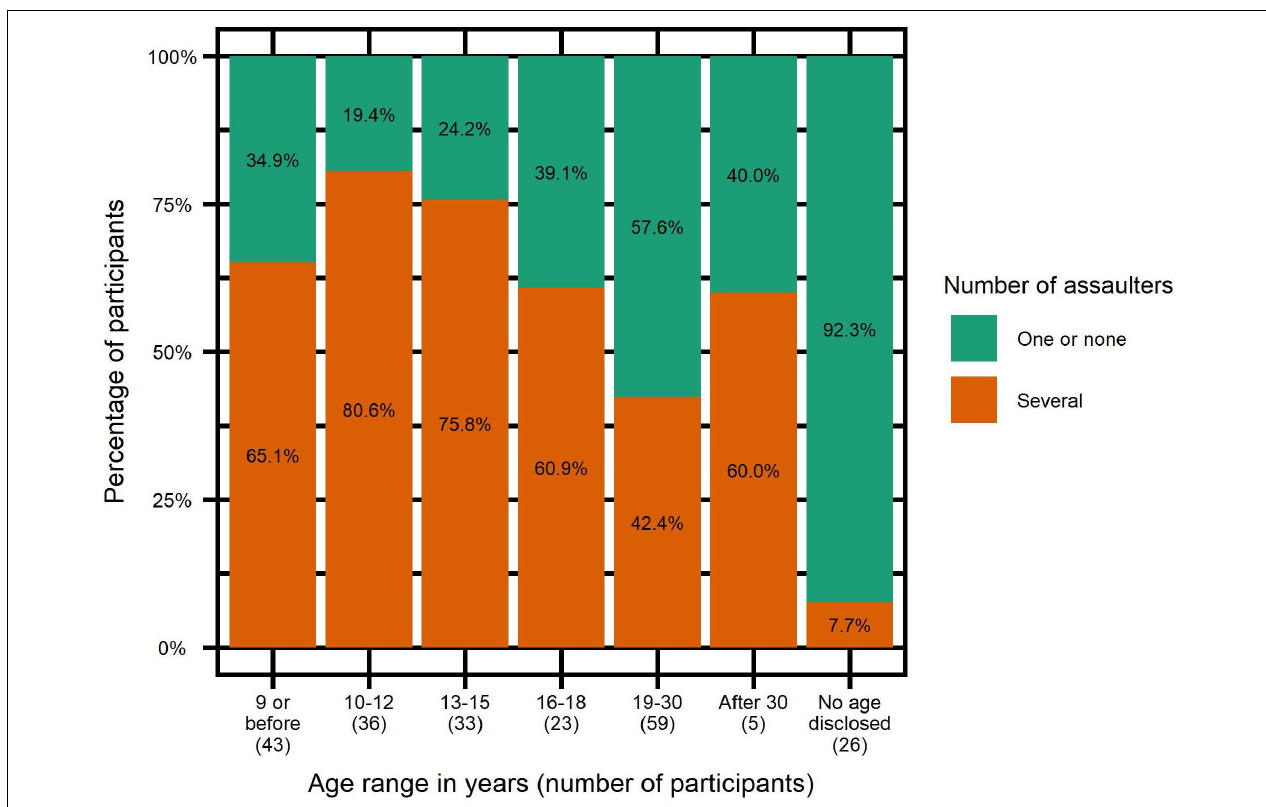
FIGURE 6 | Percentages of participants with several abusers depending on age at first assault.